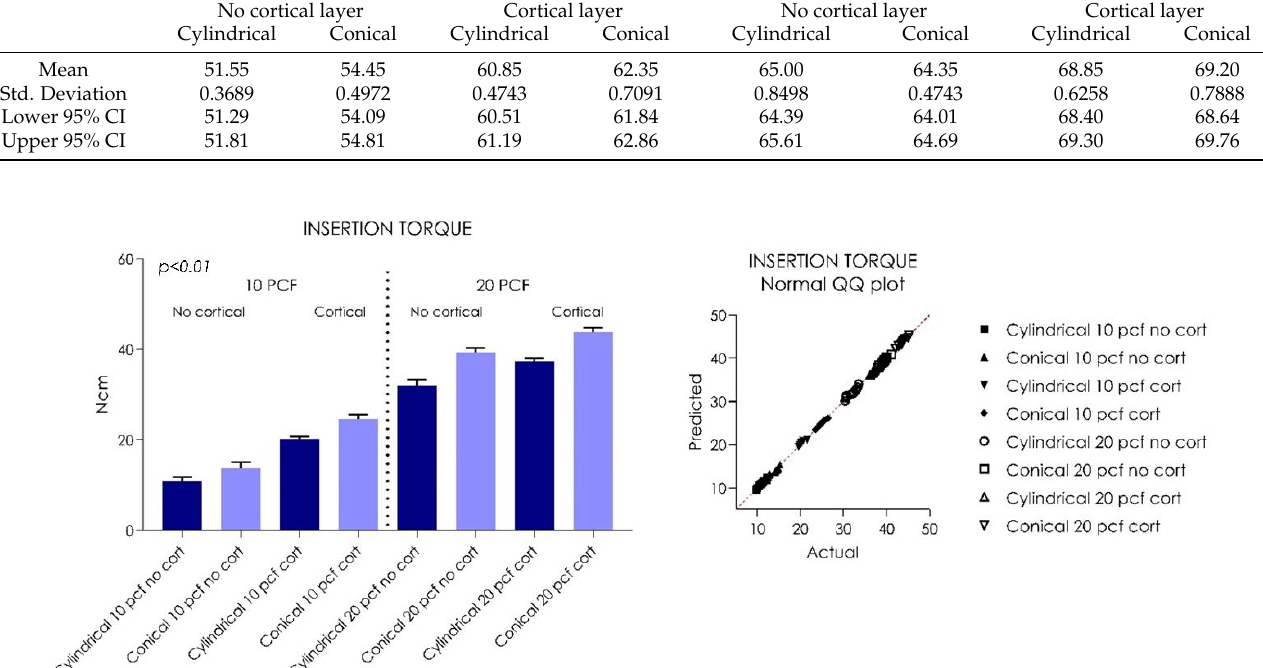
Figure 3. Graph and QQ plot values distribution showing the insertion torque (IT) values of the tested cylindrical and tapered